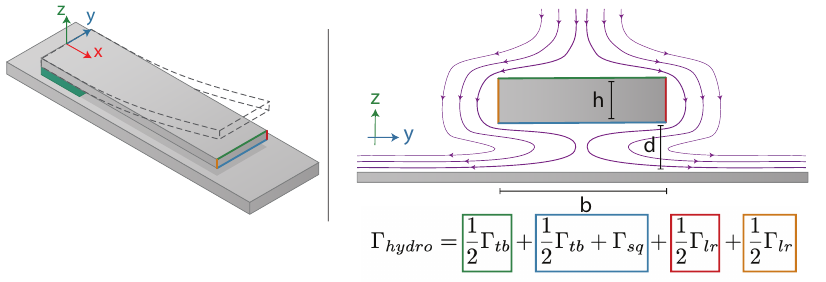
Figure 5. Scheme of streamlines acting on the cross-section sidewalls of the cantilever oscillating in its first mode of vibration with corresponding hydrodynamic functions. Γ tb is used to describe the forces applied at the top and the bottom of the cantilever, Γ lr relates to the left and right sides of the cantilever, while Γ sq is a hydrodynamic force originating from squeeze film